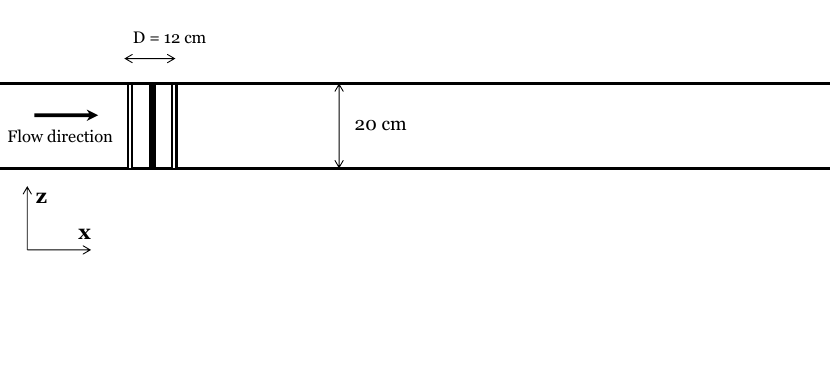
Figure 6. Schematic of x-z view of the experimental